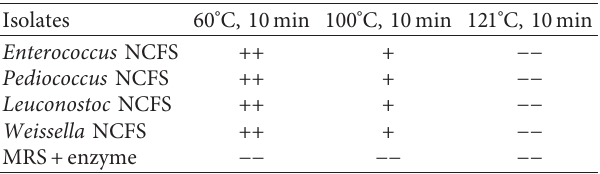
Table 6: Thermal stability of CFS produced by the selected LAB following various heat treatments ( S. aureus ATCC25923 was used as an indicator bacterium).